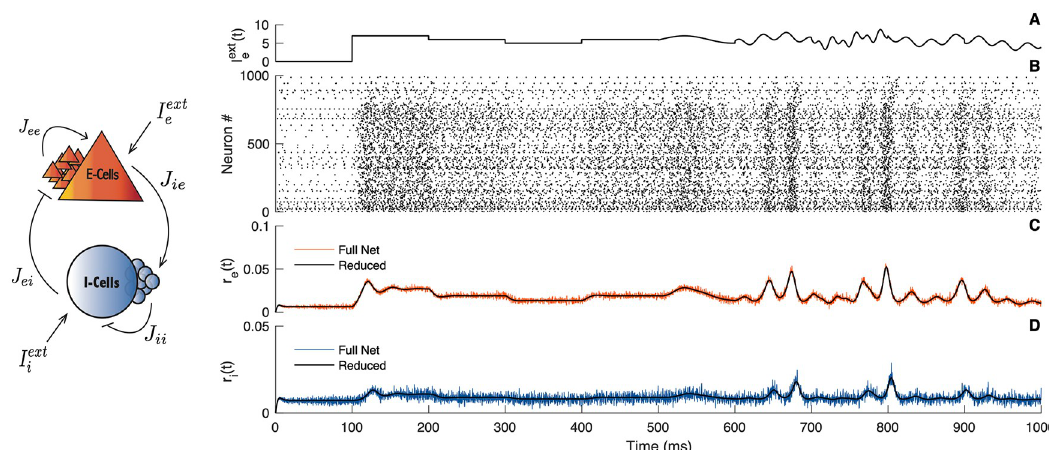
Fig 1. Comparison between the full network and the reduced system. Left panel: Schematic illustration of a canonical cortical neural network. The parameter J αβ denotes the connectivity strength of the population β onto the population α . The external influence on the population α is denoted I ext . Right panels: A) Time evolution of the stimulus I ext a obtained from simulations of the full network, the first 800 cells are excitatory, the last 200 are inhibitory. C) Firing rate of the E-cells obtained from simulations of the full network (red line) compared with the reduced system (black line). D) Firing rate of the I-cells obtained from simulations of the full network (blue line) compared with the reduced system (black line). Parameters: N ¼ � Z ¼ (cid:0) 5 ; J ee = 0; J ei = 15; J ii = 10; J ie = 15; I ext Δ e = Δ i = 1; τ e = τ i = 10; τ se = τ si = 1; � Z e i